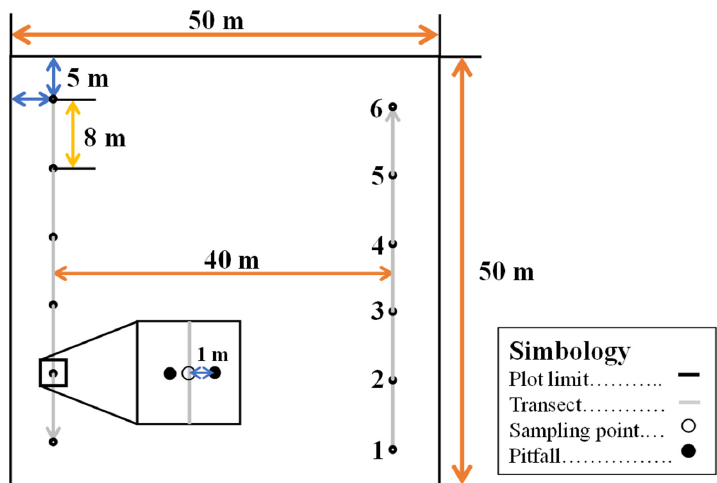
Figure 2. Transect and plot sampling